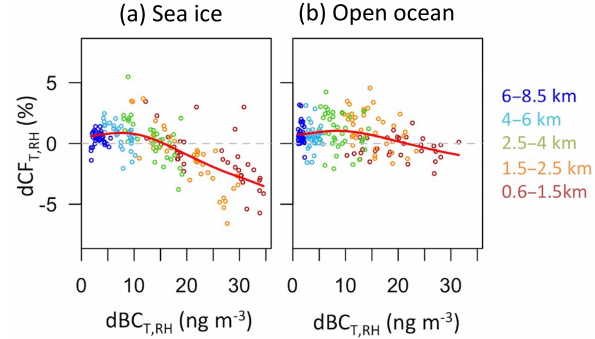
Figure 4. The relationship between d CF T, RH (%) and d BC T, RH (ngm − 3 ) over (a) sea ice and (b) open ocean at different altitude levels (color coded) for the points plotted in Fig. 1. The red line is a cubic smoothing spline of the data among all altitudes. In or- der to avoid obscuring emergent properties of the full dataset, the data include all meteorological conditions, including those where d CF T, RH values are not significantly different from zero (as noted by white Xs in Fig.